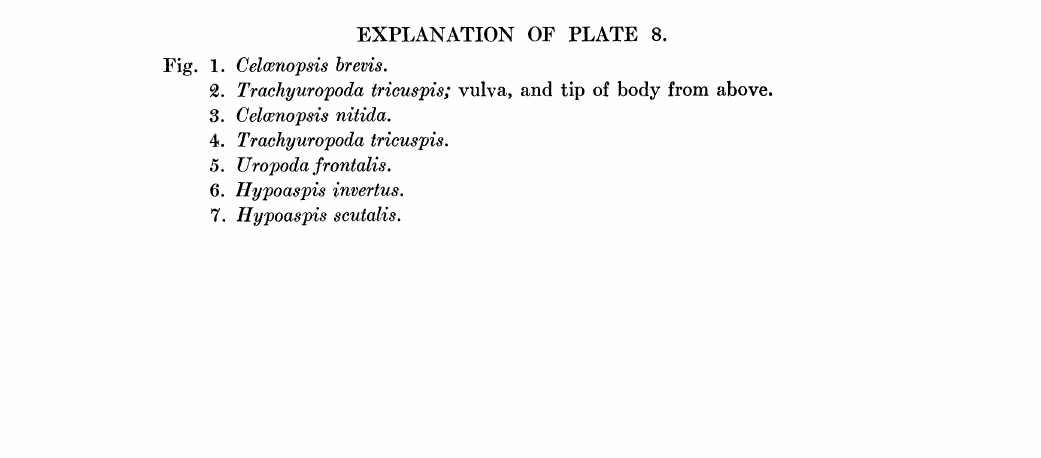
. Fig. 1. Celenopsis brevis. Trachyuropoda tricuspis; vulva, and tip of body from